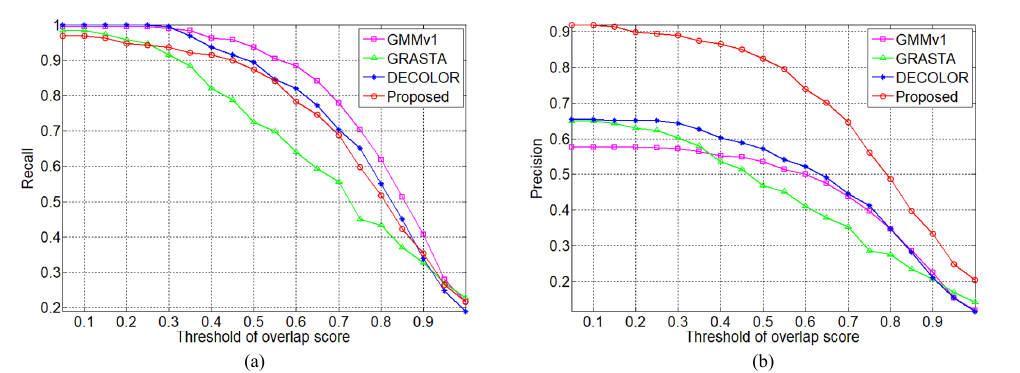
Figure 5. Curves of recall and precision with different threshold of overlap scores for flying small target detection on visible image sequence ( a ) recall and ( b )